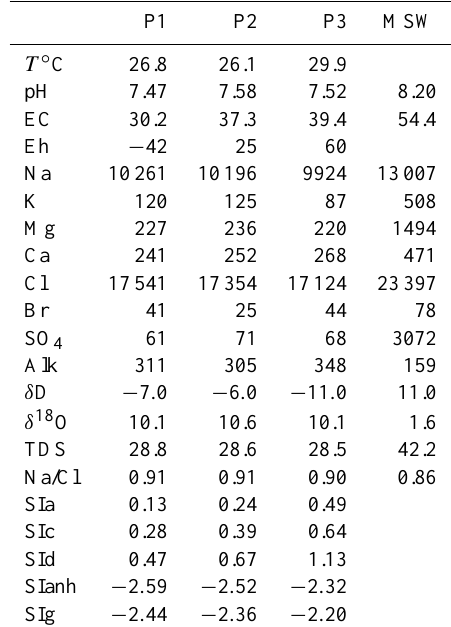
Table 1. Physico-chemical parameters and concentrations of ma- jor elements in the collected waters. Water temperature is ex- pressed in ◦ C, EC (=electrical conductivity) in mScm − 1 , pH in pH units, Eh in mV. Concentrations are expressed in mgl − 1 and TDS in gl − 1 . Alk=total alkalinity reported as HCO 3 . Isotopic com- position is reported in delta per mil vs. V-SMOW. SI=saturation index: a=aragonite; c=calcite; d=dolomite; anh=anhydrite;